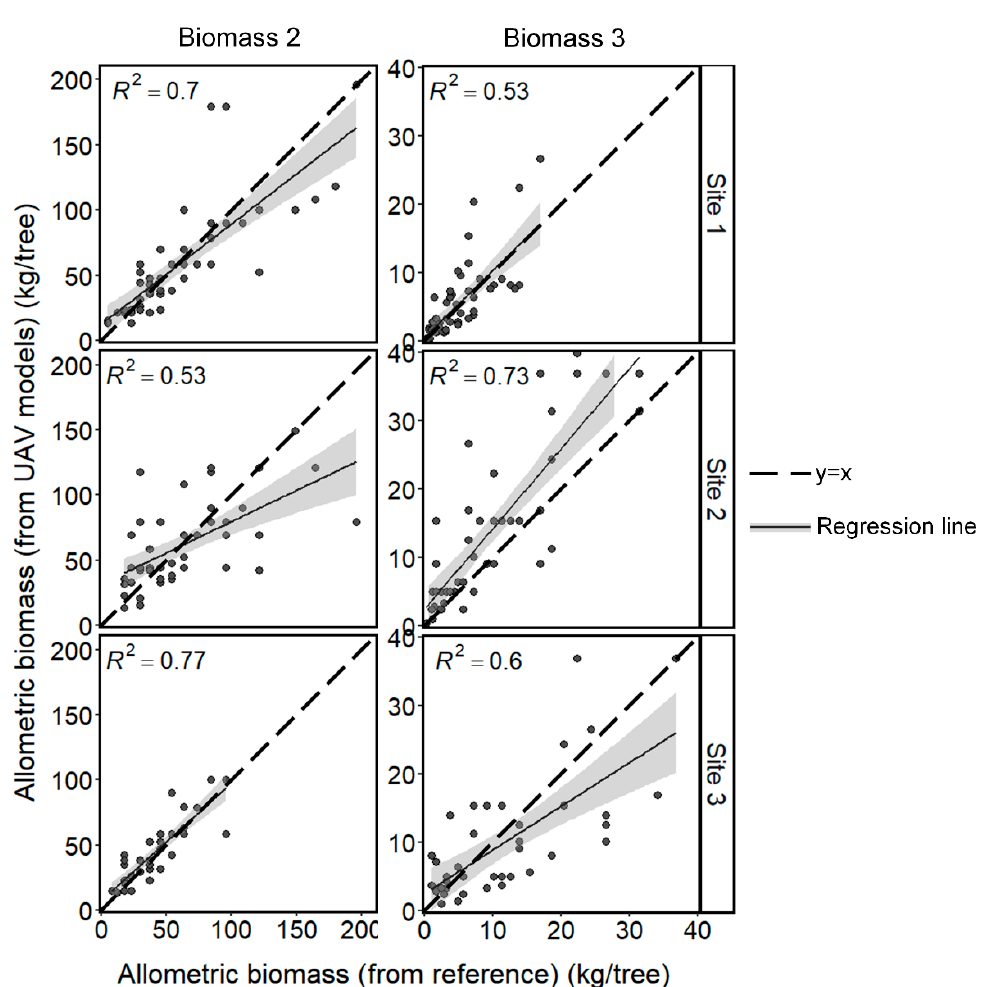
Figure A4. Site-specific AGB values obtained from allometric equations on variables measured by UAV (vertical axis) and reference values (horizontal axis) in high stands in Zone 1.